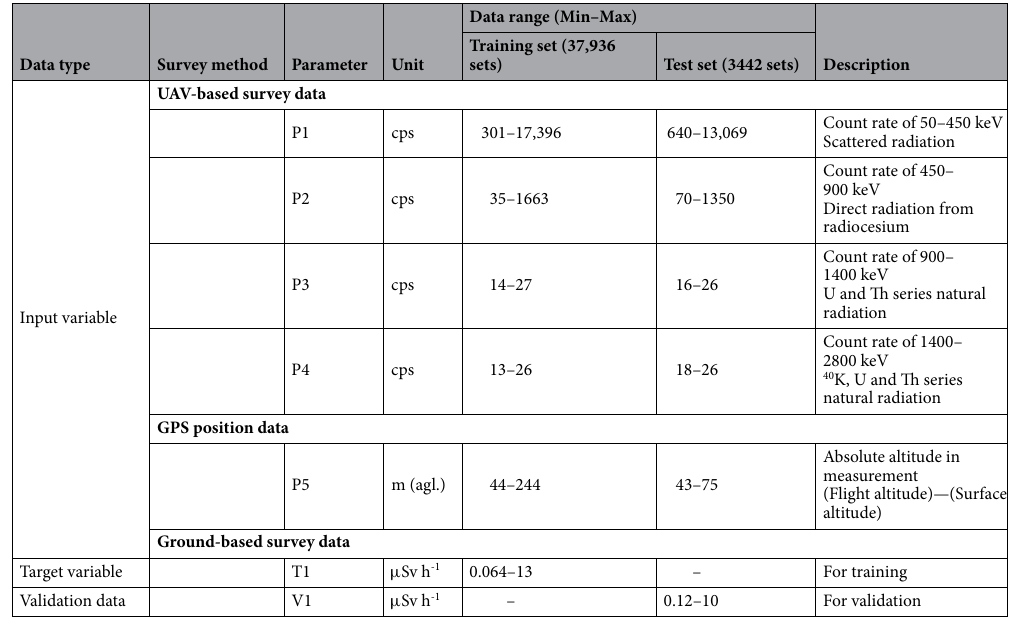
Table 1. List of training and test